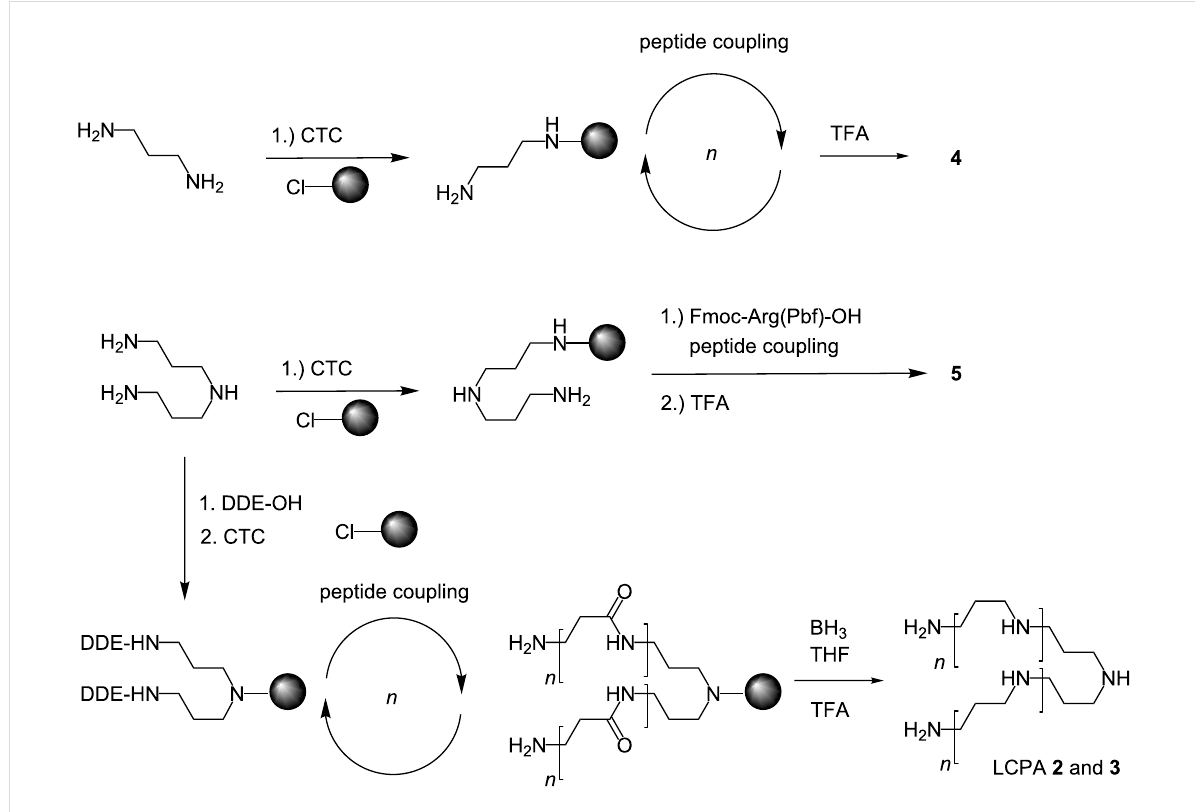
Figure 3: Three synthetic strategies for oligoamines and cationic peptides. The CTC-resin is shown as a grey ball and the arrows represent the coupling and Fmoc deprotection step. The letter n stands for the number of coupling and deprotection cycles. DDE = 1-(4,4-dimethyl-2,6-dioxocy- clohex-1-ylidene). Top and center: Propylenediamine or bis(3-aminopropyl)amine acts as a spacer for the solid-phase peptide synthesis on CTC- resin. Bottom: Chain extension at both ends of a